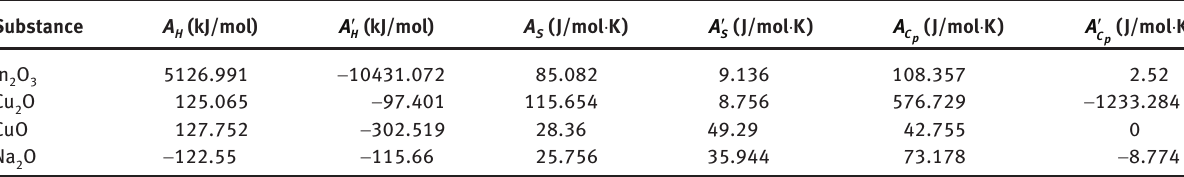
Table 4: The parameter value of A and A